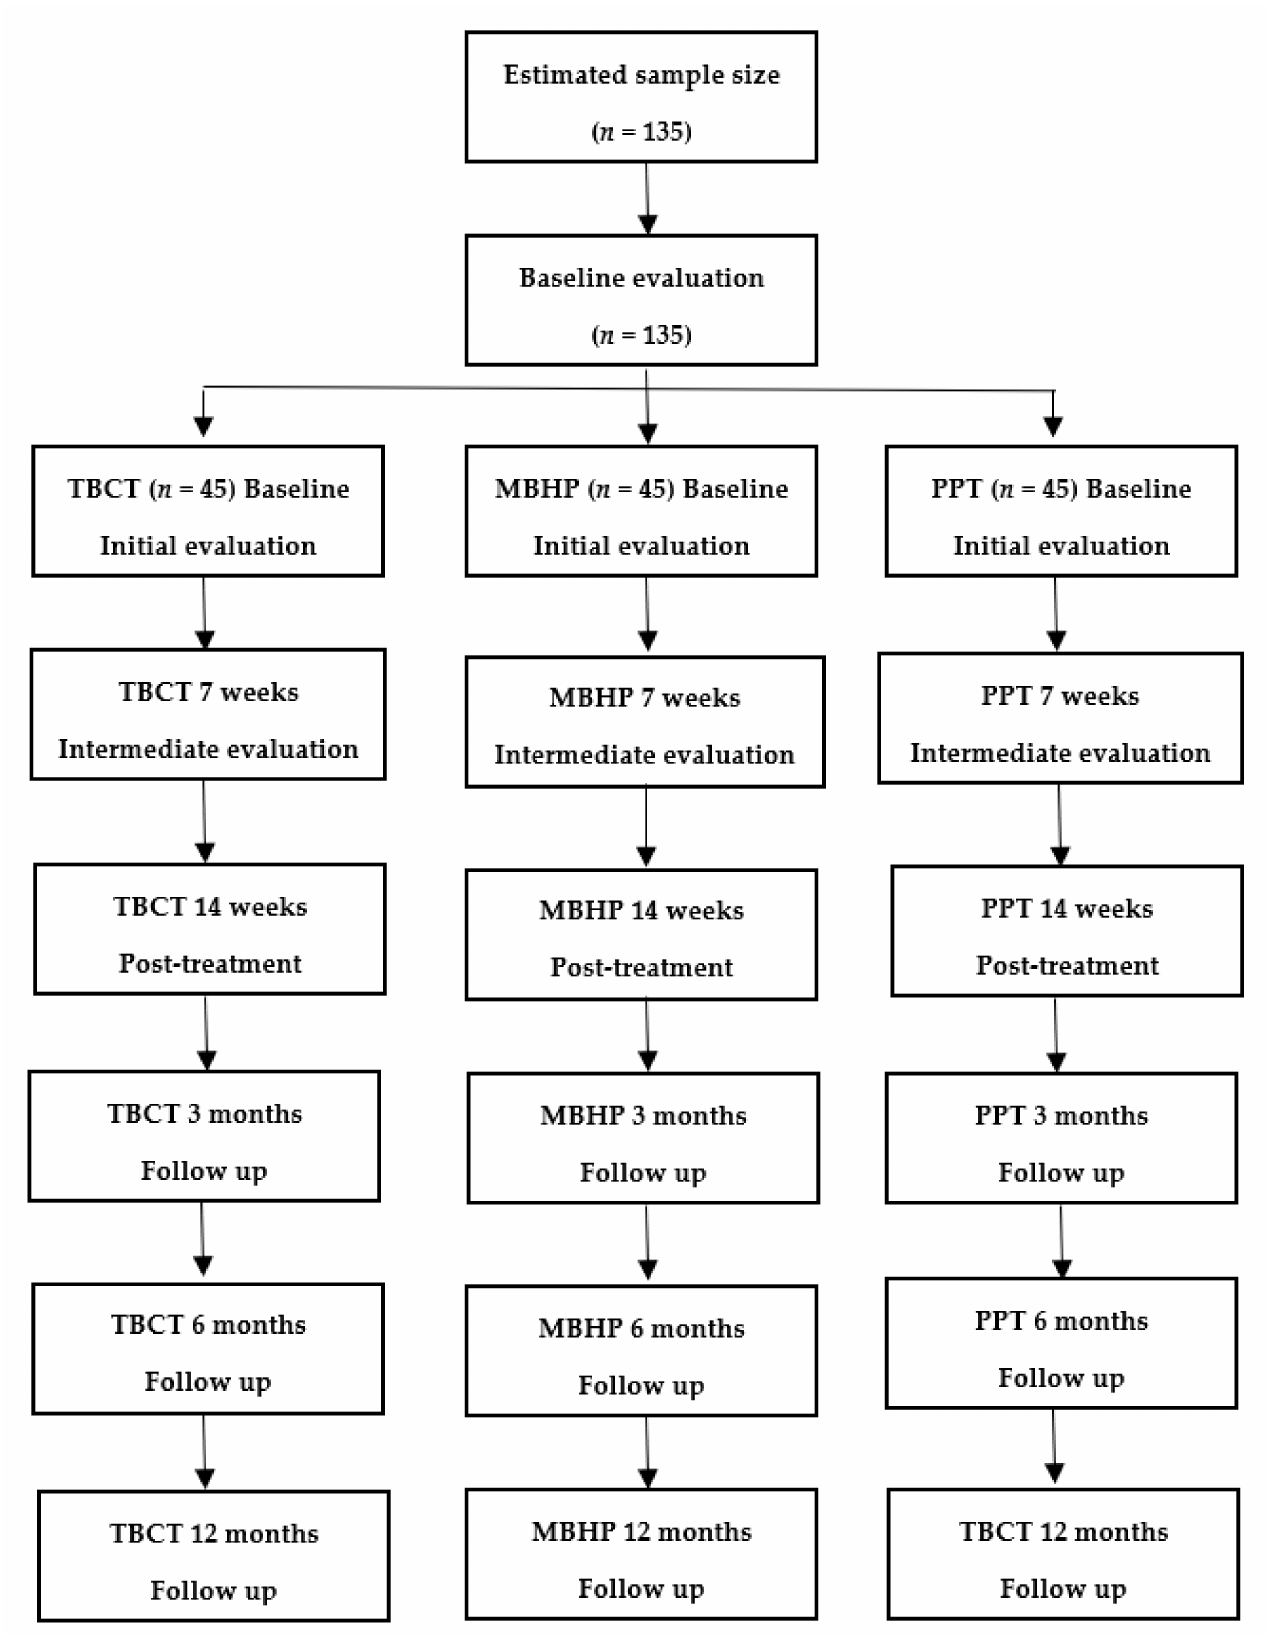
Figure 1. Flowchart of study (CONSORT) TBCT: trial-based cognitive therapy; MBHP: mindfulness- based health promotion; PPT: positive